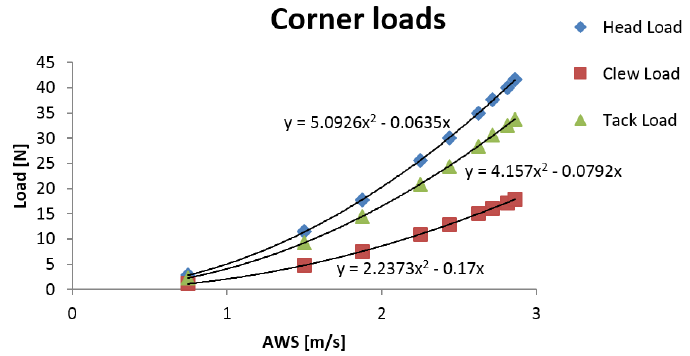
Figure 17. Plots of the corners loads vs. AWS for AWA = 120° and Δ α g = 20°